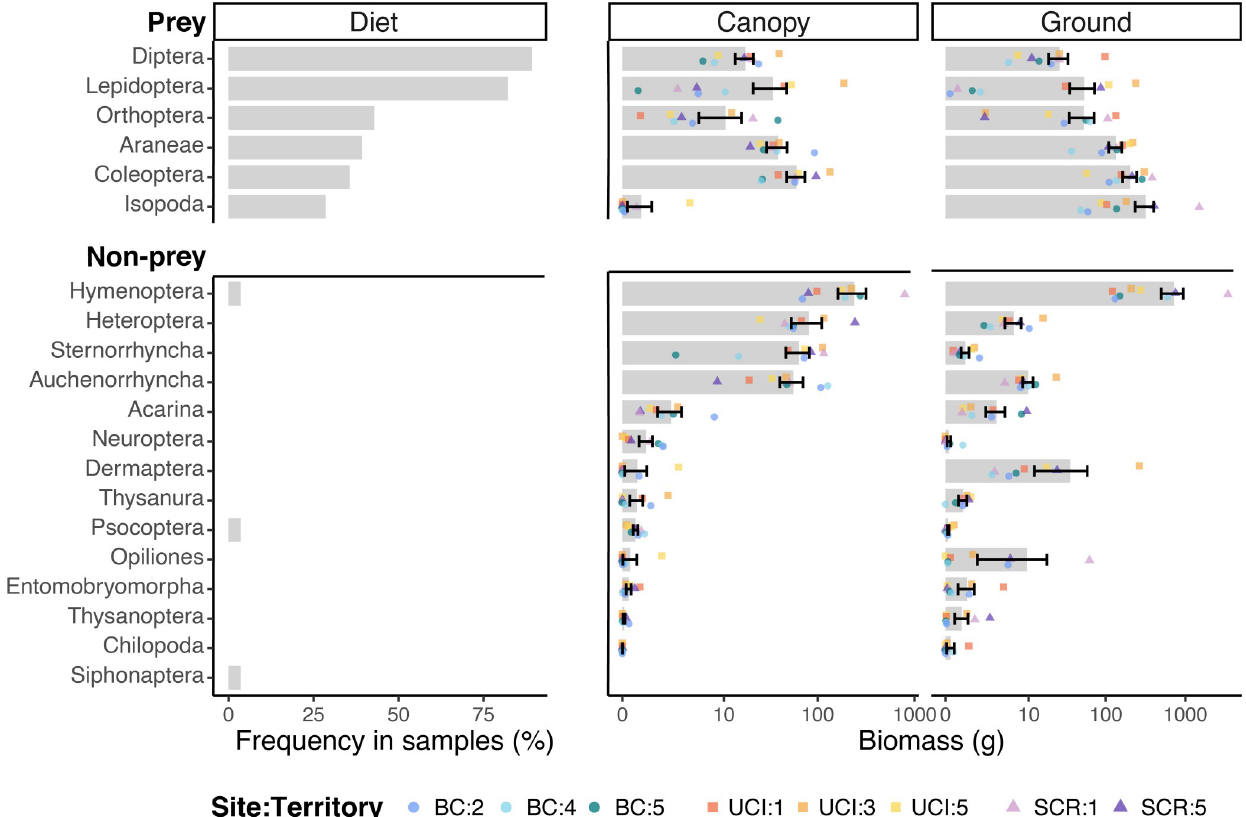
Fig 2. Arthropod orders and suborders in (a) Coastal Cactus Wren diet samples and (b) nesting territories. Arthropod taxa are ranked by the frequency of occurrence among diet samples. The total estimated biomass is given at the territory-scale for canopy and ground arthropods. Symbols show the variation in estimated biomass among territories (color) and site (shape). Grey bars show the mean biomass (+ SE) across all territories (n = 8). Biomass estimates are drawn on a log scale.